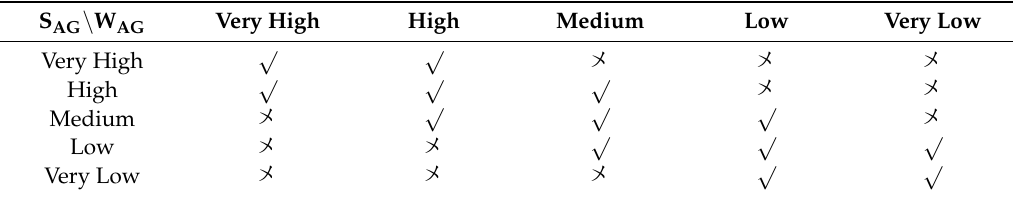
Table 3. Weighted Global Activity Classification.